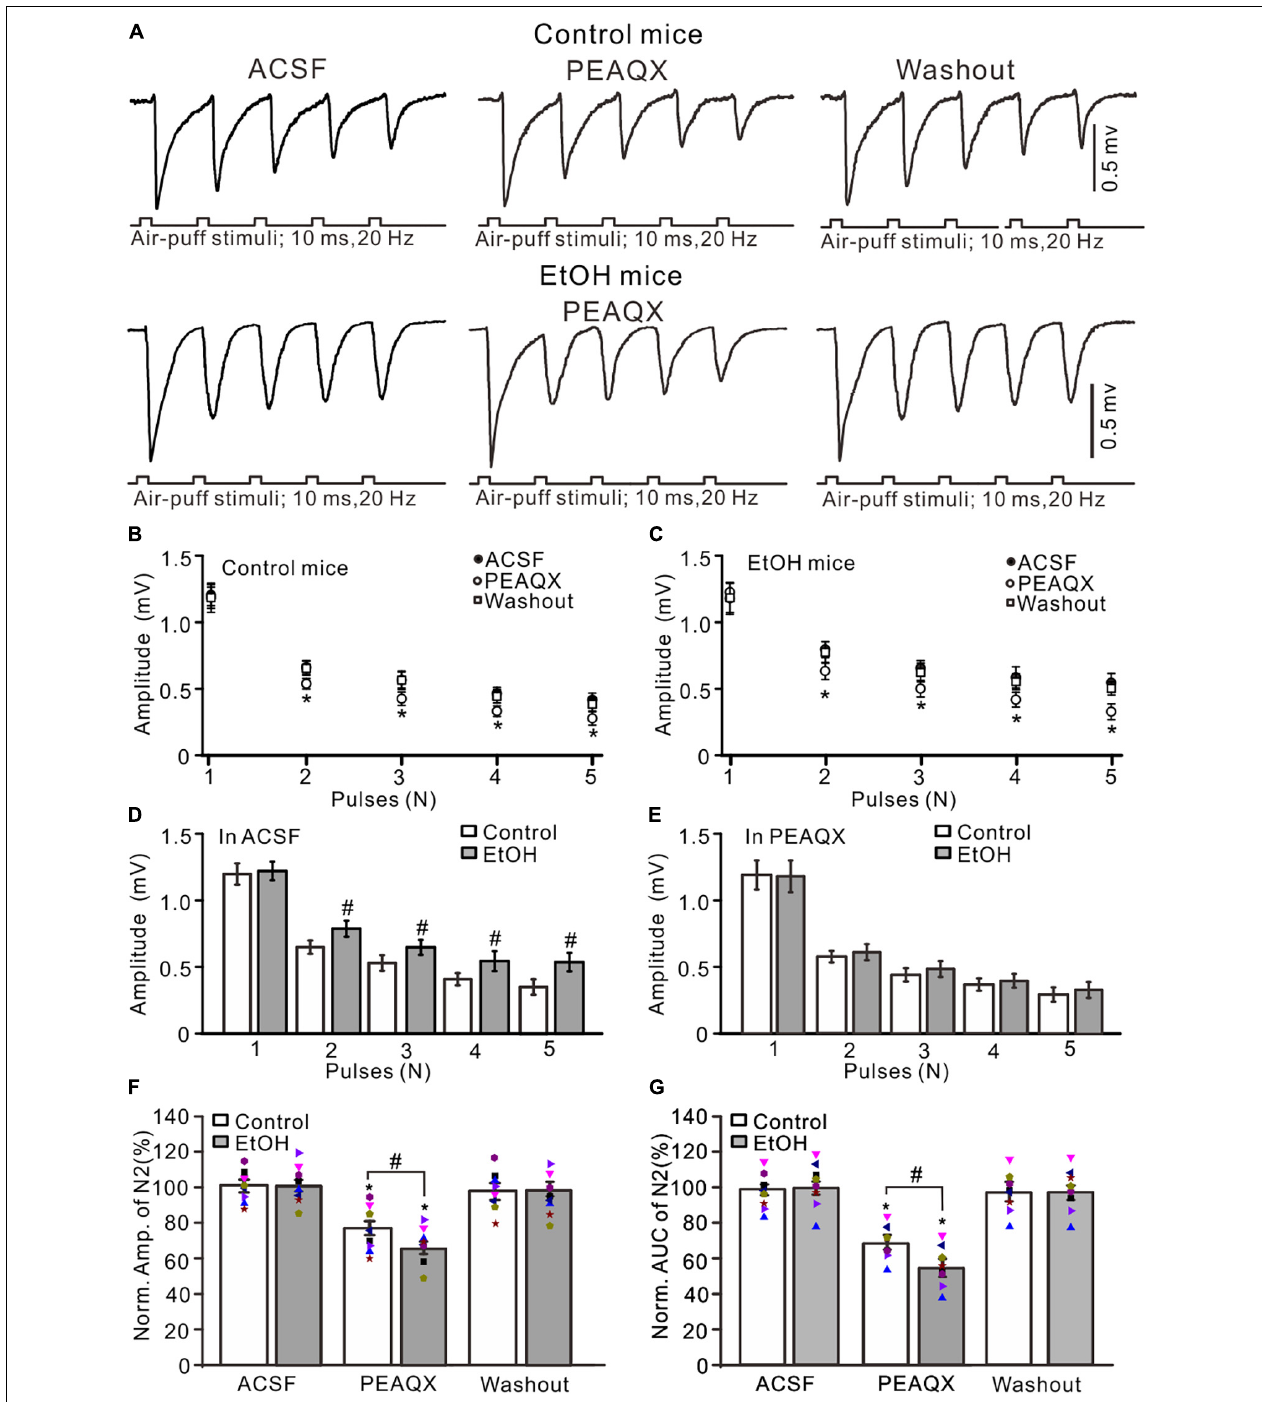
FIGURE 3 | Blockade of GluN2A abolished the chronic ethanol exposure-induced enhancement of facial stimulation-evoked MF–GC synaptic transmission. (A) Representative field potential traces showing that the air-puff stimuli (10 ms, 60 psi; 5 pulse, 20 Hz) on the ipsilateral whisker pad evoked field potential responses, recorded from the GL of control (upper) and ethanol-exposed mice in treatments of ACSF, PEAQX (10 µ M), and recovery (washout). (B) Summary of data showing the absolute ( ± SEM) amplitudes of N1–N5 in treatments with ACSF, PEAQX, and recovery (washout) in control mice. (C) Summary of data showing the absolute amplitudes of N1–N5 in treatments with ACSF, PEAQX, and recovery (washout) in ethanol-exposed mice. (D) Bar graph showing the mean amplitude of peaks recorded in the presence of ACSF in control and ethanol-exposed mice. (E) A bar graph showing the mean amplitude of peaks recorded in the presence of PEAQX in control and ethanol-exposed mice. (F) A bar graph with individual data (Symbols of different colors) showing the normalized amplitude of N2 in each treatment. (G) A bar graph with individual data (Symbols of different colors) showing the normalized AUC of N2 in treatments with ACSF, PEAQX, and recovery (washout). n = 8 in each group. * P < 0.05 vs. ACSF; # P < 0.05 vs. control.